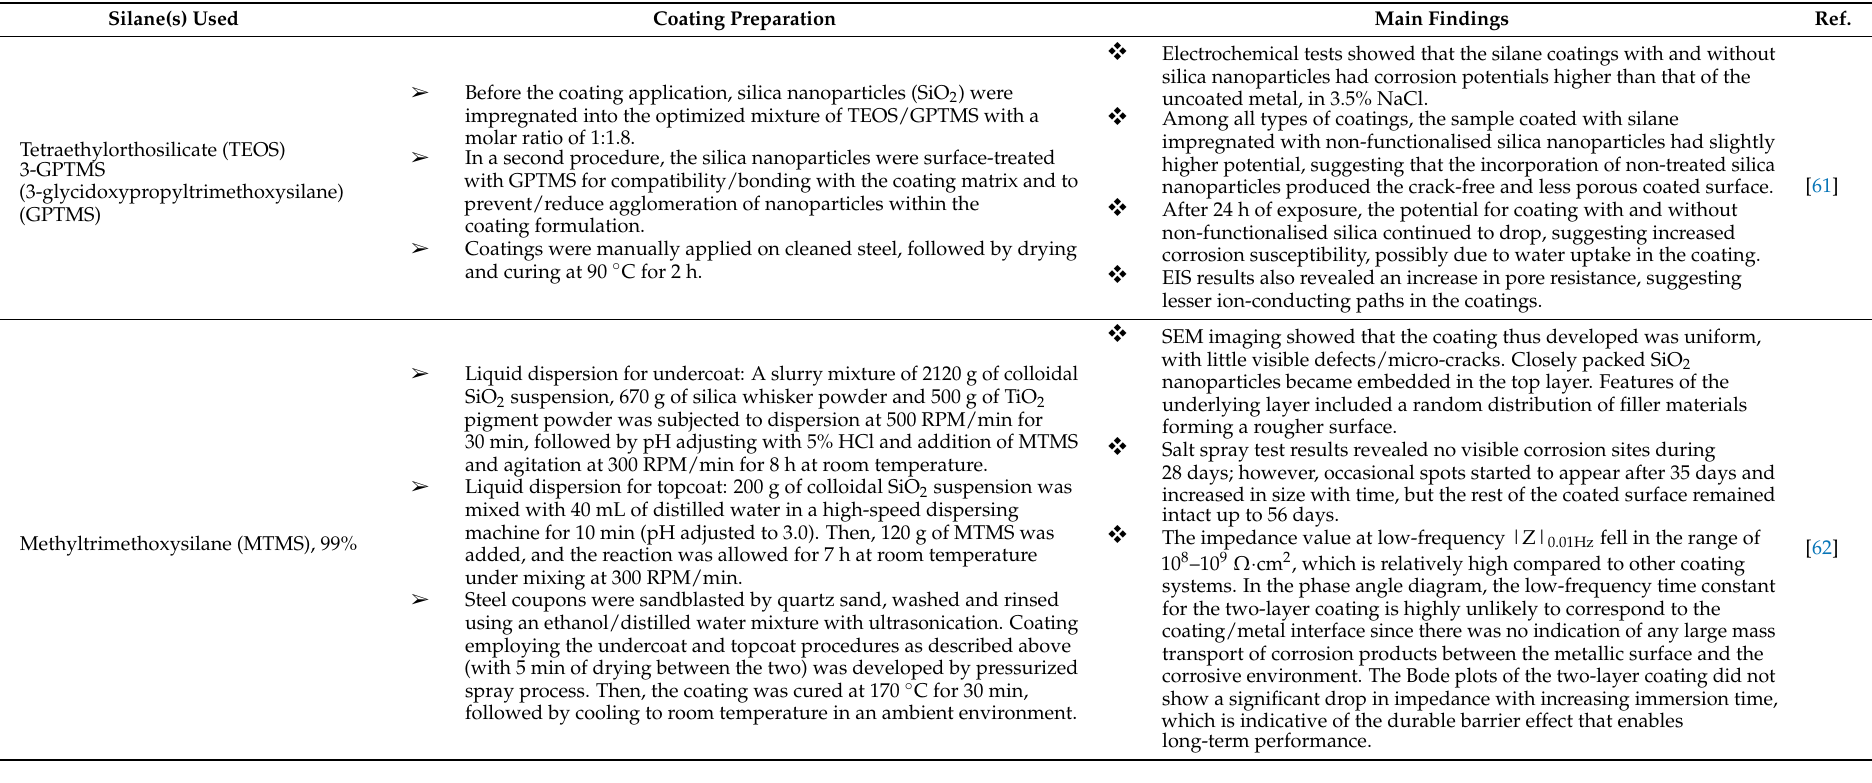
Table 1. Different approaches for improving silane coatings and the main findings, as reported in the